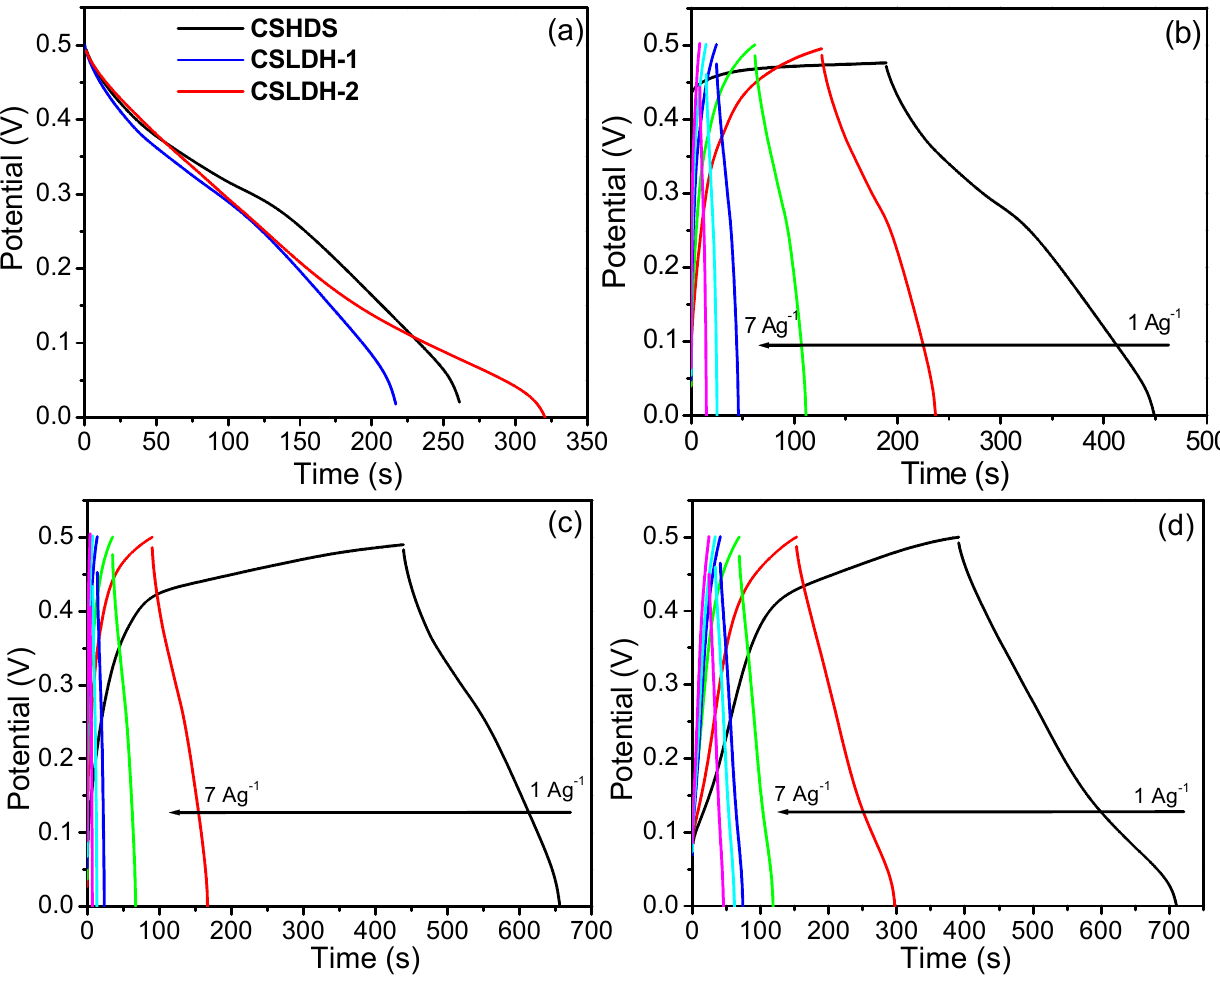
Figure 12. ( a ) Comparative CD curves of CSHDS, CSLDH-1 and CSLDH-2 fix current density of 1 Ag − 1 ; ( b ), CD curves of CSHDS; ( c ) CSLDH-1; and ( d ) CSLDH-2 at different current densities.